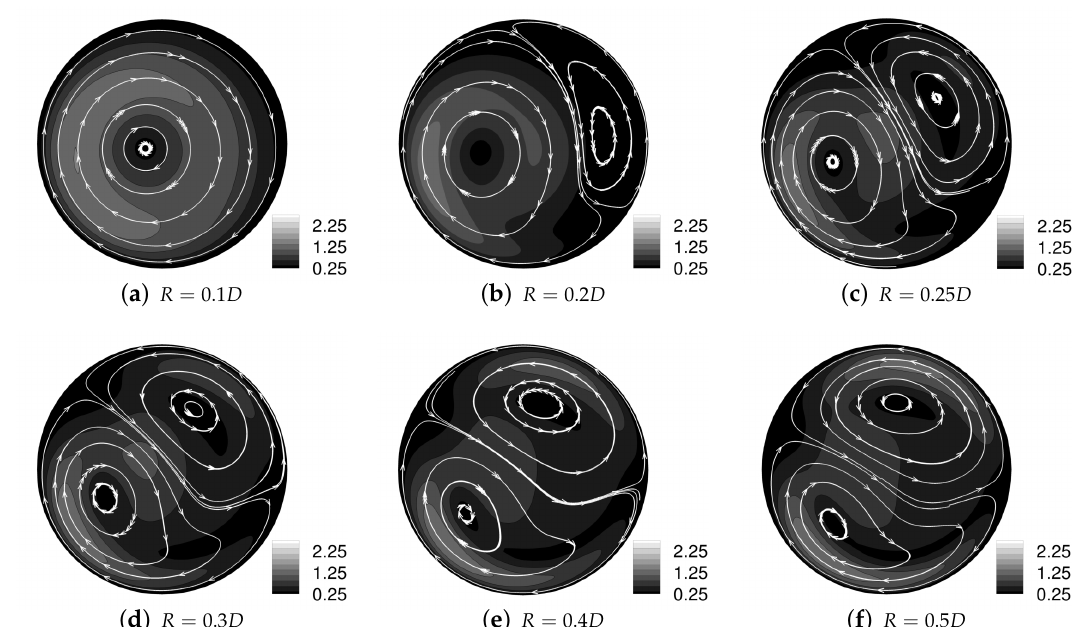
Figure 3. In-plane streamtraces and contours of in-plane velocity magnitude for a single helical geometry—for R = 0.2 D a second vortical structure emerges in the upper-right portion of the cross-section. As R is increased, this second vortex increases in size and the dividing line between the two vortices tends towards the horizontal. (Reprinted from Journal of Computational and